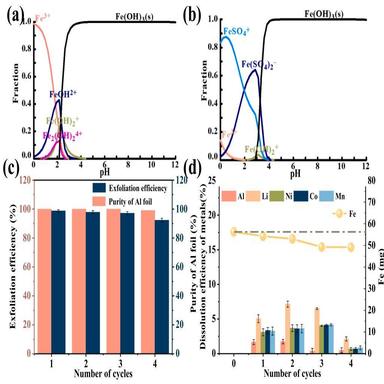
The form of Fe3+ in (a). Aqueous solution and (b). USFH at pH range of 0–12; (c) Exfoliation efficiency and purity of Al foil and (d) leaching efficiencies of different metals in circulating experiments using solutions from the USFH (Condition: S2O8 2− dosage- 0.02 M, temperature- 35 ◦C, ultrasonic power- 100 W, time- 5 min and initial pH solution is 2.0).